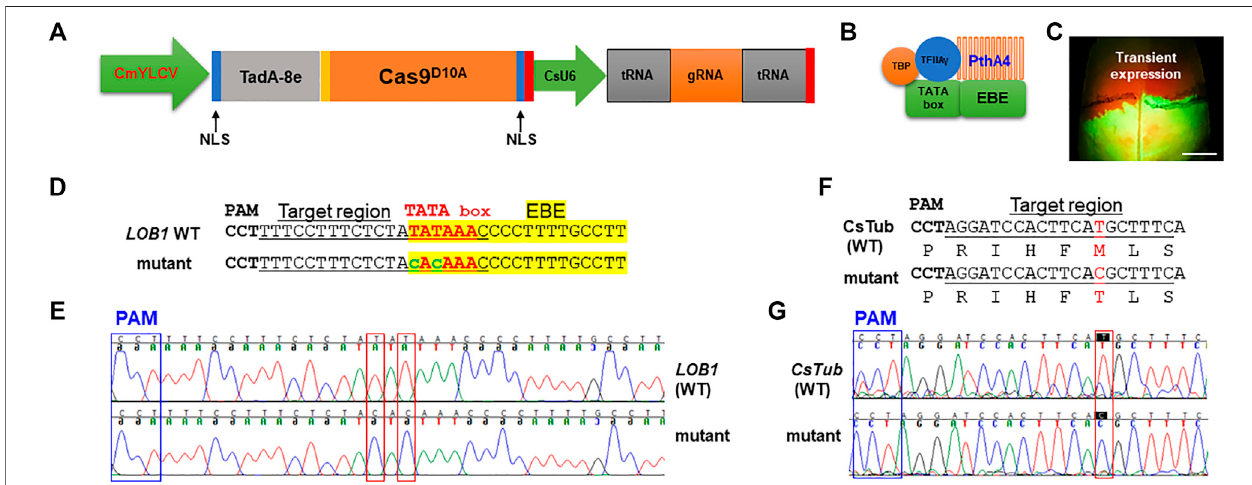
FIGURE 1 | Precise gene editing in citrus with adenine base editor ABE8e via transient expression. (A) Illustration of ABE8e adenine base editing (ABE) system for citrus. CmYLCV (Huang et al., 2022), Cestrum yellow leaf curling virus promoter; TadA-8e (Richter et al., 2020), evolved Escherichia coli tRNA adenosine deaminase; Cas9 D10A , Cas9 nickase; NLS, nuclear localizationsignal;CsU6, citrus U6promoter. (B) TATAbox locatedupstreamofthe LOB1 EBE region isassociatedwith general transcription factors and the TAL effector PthA4 of Xanthomonas citri subsp. citri ( Xcc ). (C) Xcc -facilitated transient expression of the PC-CmYLCV-ABE8e-LOB1 construct in citrus leaf. The construct carries a GFP expression cassette. Scale bar, 1 cm. (D) Editing of TATA in the TATA box of the LOB1 promoter into CACA in transient assay. Underlined nucleotides were selected for gRNA design (gRNA: GTTTATATAGAGAAAGGAAA); EBE, Xanthomonas TAL effector binding element, highlighted with yellow; TATA box, in red font; edited sequences, in lower case with green font. (E) Chromatograms for (D) , LOB1 WT (upper), and mutant (lower). Mutation sites are indicated within red rectangles. (F) Editing of the CsTub gene ( Cs1g21050 ) in the transient expression assay. The amino acids are aligned under the corresponding DNA sequences. The mutation of T to C changes the corresponding amino acid from methionine (M) to threonine (T). (G) Chromatograms for (E), CsTub WT (upper) and mutant (lower). Mutation sites are indicated within red